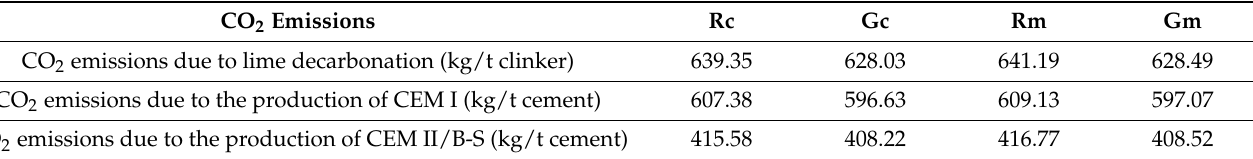
Table 7. Calculated CO 2 emissions associated with clinker and cement